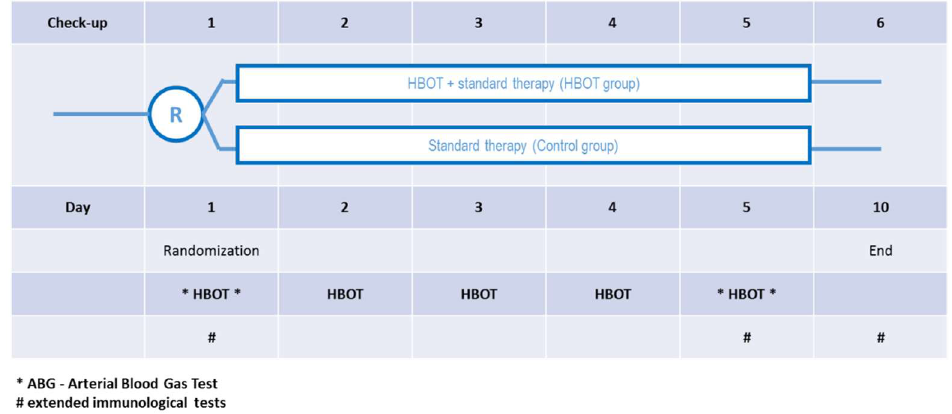
Figure 2. Protocol of Randomised Clinical Trial of Hyperbaric Oxygen Therapy in SARS-CoV-2 pneumonia.